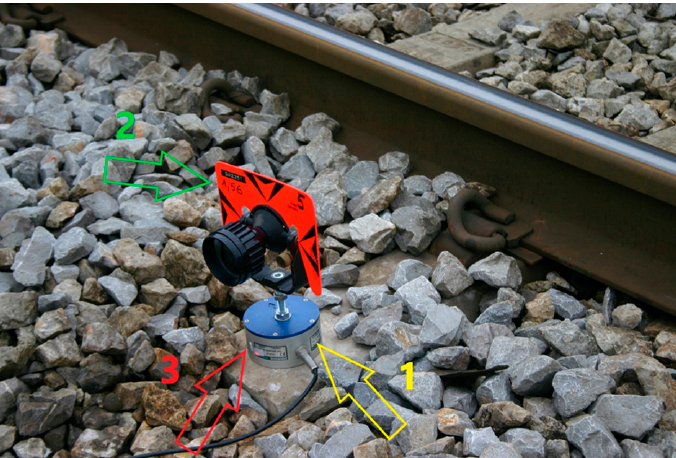
Figure 1. Typical cracks in the prestressed reinforced concrete railway sleepers investigated.